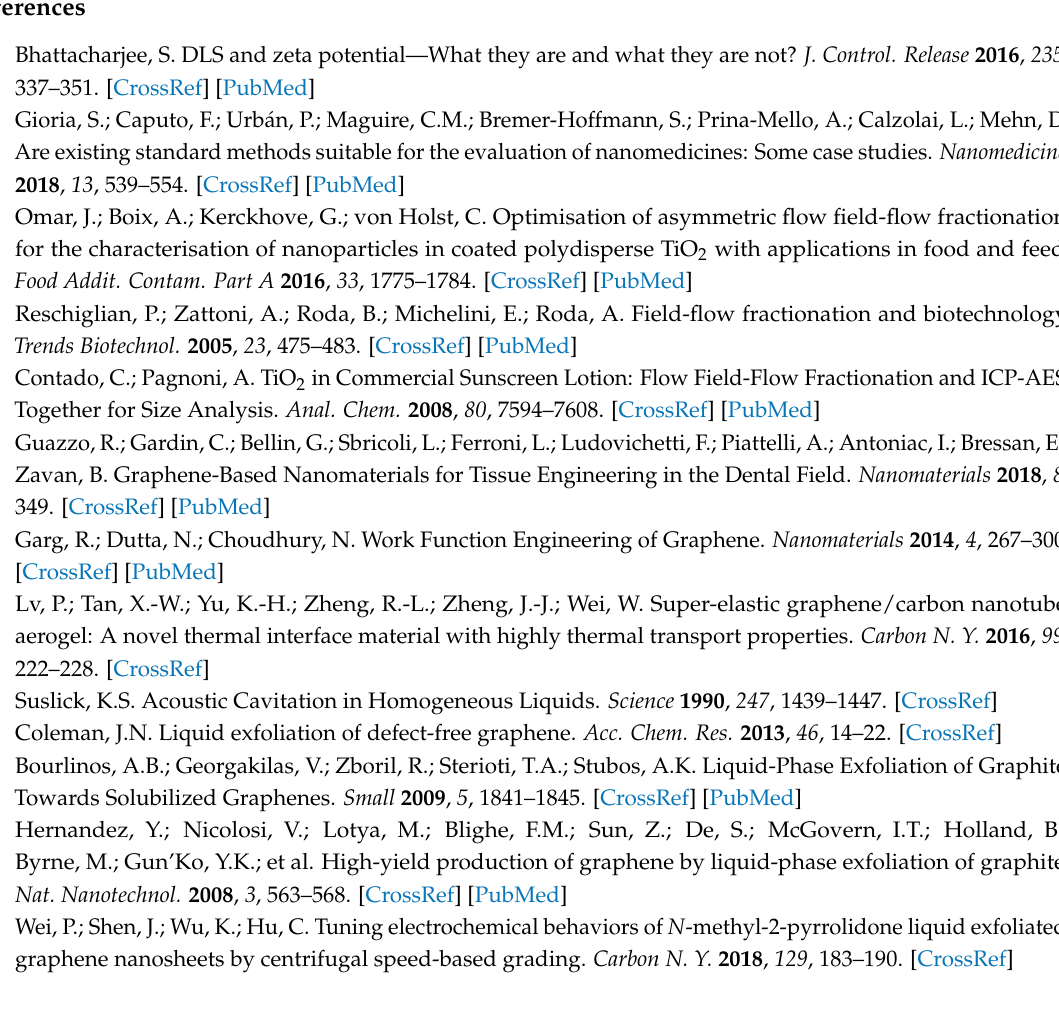
Figure S1: Calorimetric curve and linear fitting for the operational calibration of the ultrasonic equipment used for the GNS synthesis; Figure S2: NTA graph that represents GNS particle size and intensity; Figure S3: Nanoparticle tracking analysis images of GNS; Figure S4: Random Coil data fitting method; Figure S5: Analysis of the fractal factor dimension to identify the GNS particle shape where M is molecular weight and r is the radius of gyration. Author